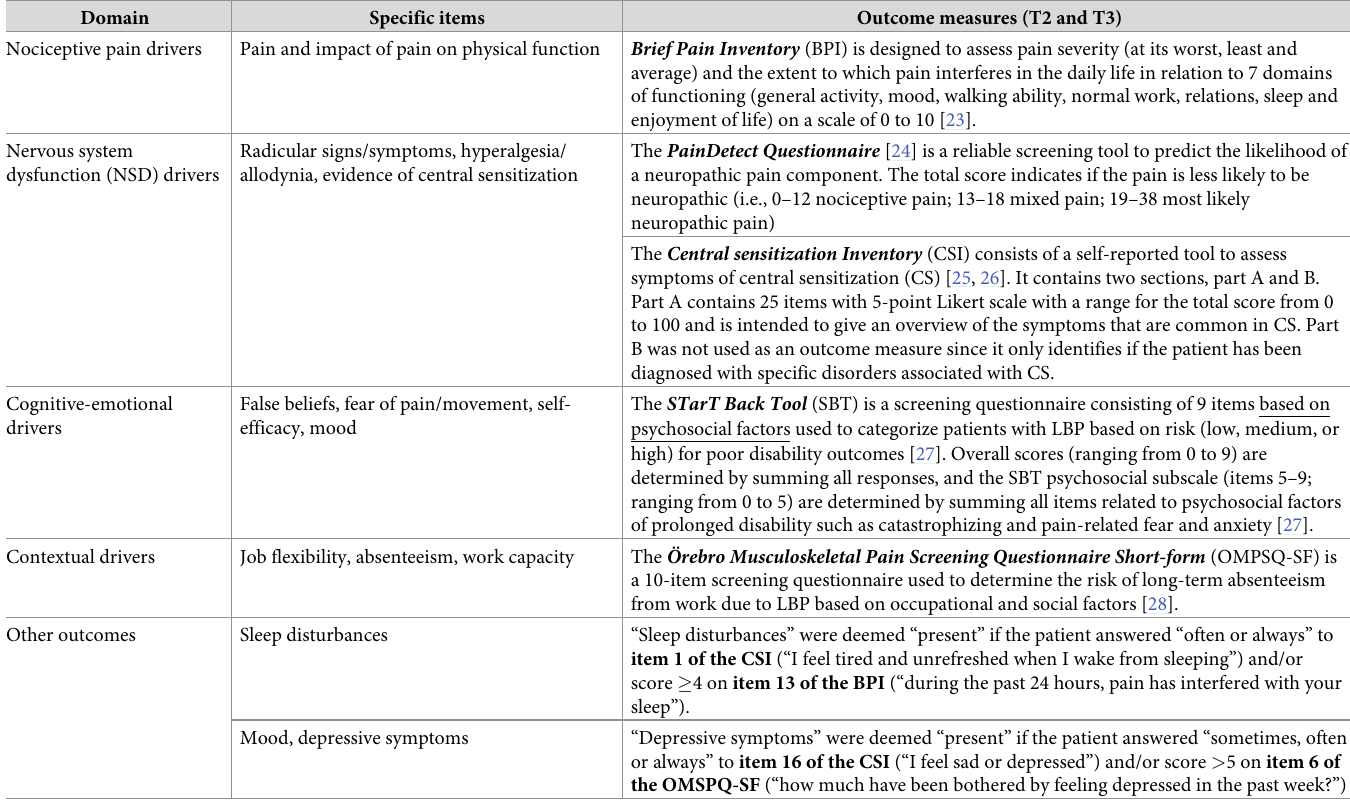
Table 1. Preliminary effect outcome